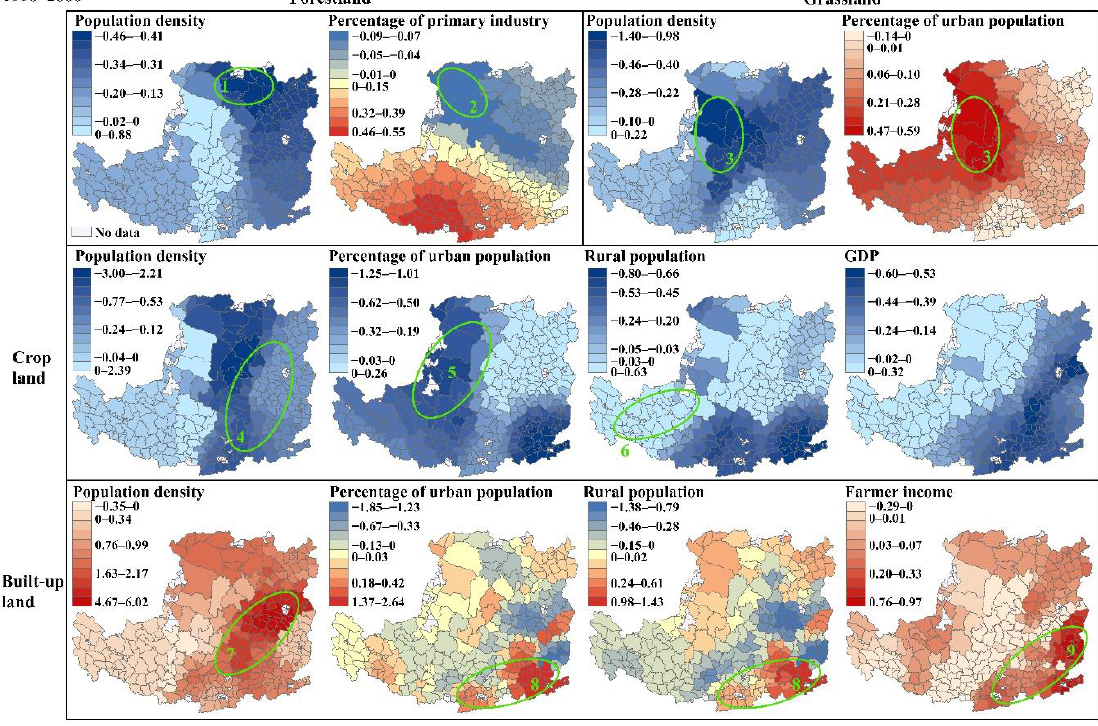
Figure 8. GW regression coefficient estimates for changes of four land-use types from 1990 to